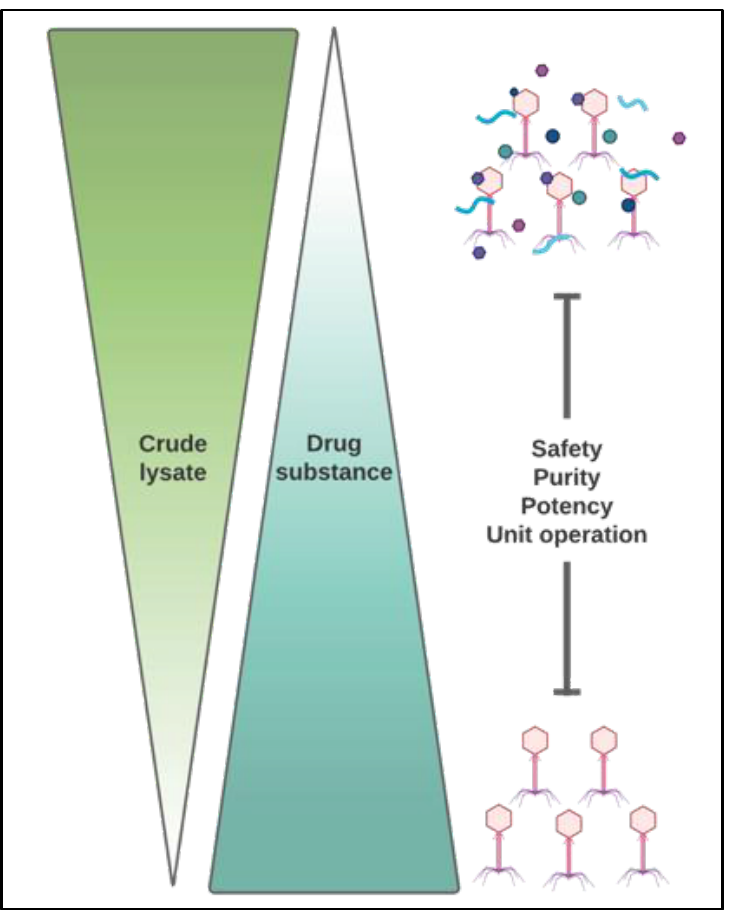
Figure 4. It is important to realize that crude lysate starts becoming DS and needs to be treated as such. The process developer should consider the critical quality attributes that are measured along the downstream separation cascade.